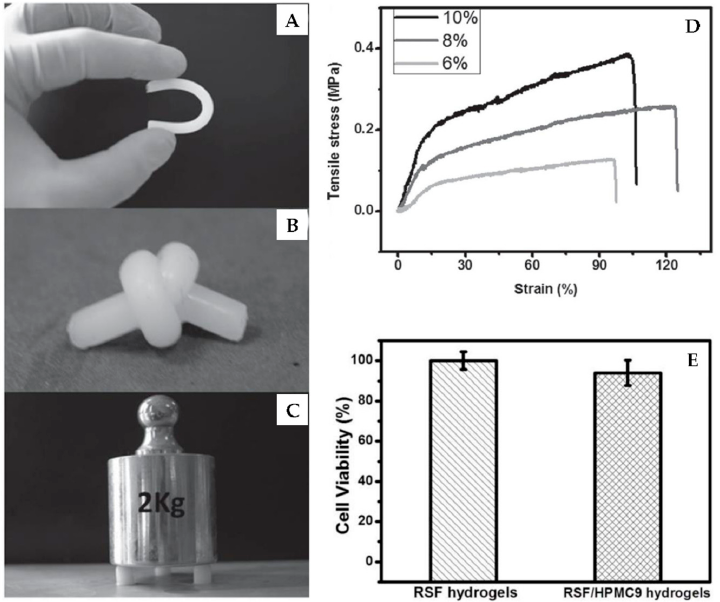
Figure 5. Images of regenerated silk fibroin (RSF)/hydroxypropyl methyl cellulose 9 (HPMC9) hydrogels’ reaction to bending ( A ), knotting ( B ) and compressing ( C ); ( D ) Representative tensile curves of RSF/HPMC9 hydrogels with different solid contents; ( E ) Cytotoxicity test of mouse fibroblast cells cultivated with RSF hydrogels and RSF/HPMC9 hydrogels; RSF/HPMCP9: the ratio of RSF to HPMC was 9/1. Reproduced from [34].